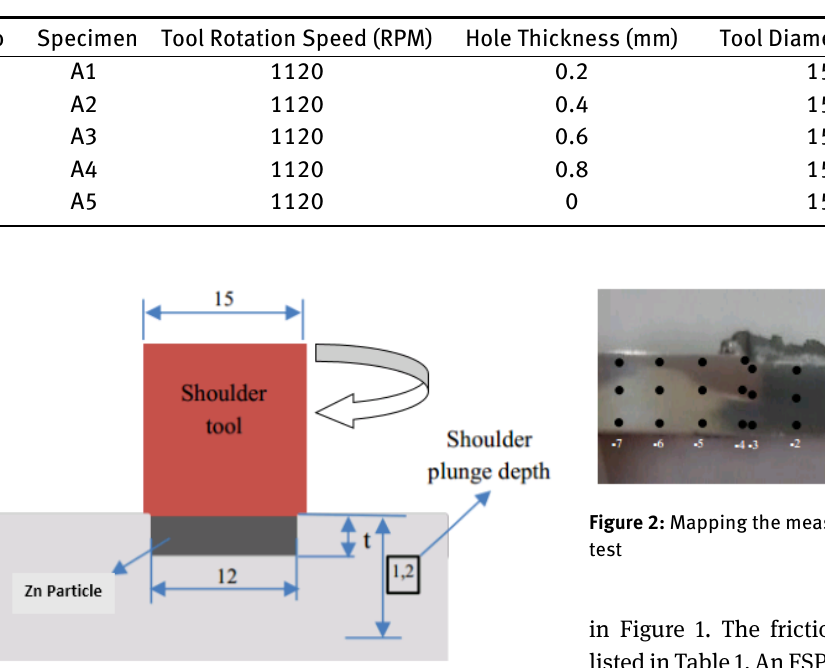
Figure 1: Schematic diagram of friction stir processing of aluminium